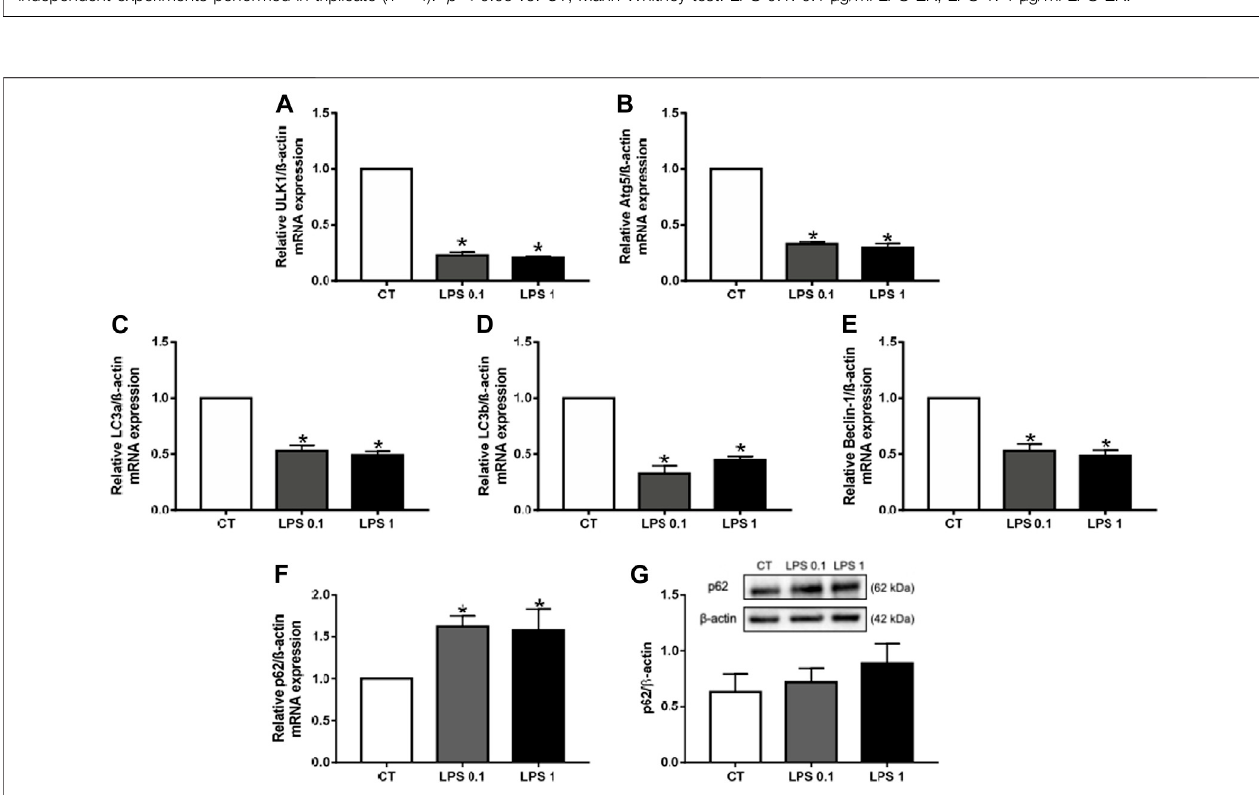
FIGURE 4 | Lipopolysaccharide-EK (LPS-EK) decreases autophagy in macrophages. RAW cells were incubated with LPS-EK for 6 h. Gene expression of the autophagymarkers (A) ULK1, (B) Atg5, (C) LC3a, (D) LC3b, (E) Beclin-1,and (F) p62wasthenquanti fi edbyRT-qPCRandnormalizedtothatofthehousekeepinggene ß-actin. (G) p62proteinexpression wasstudied bywesternblottingandnormalized tothatofthehousekeepinggeneß-actin.Dataareexpressed asthemean±SEMof four independent experiments performed in triplicate ( n = 4). * p < 0.05 vs . CT, Mann-Whitney test. LPS 0.1: 0.1 µg/ml LPS-EK, LPS 1: 1 µg/ml LPS-EK.